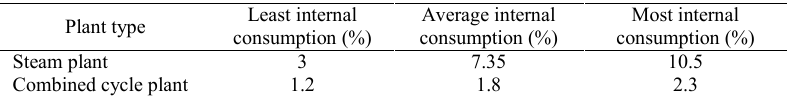
Table 2: Plant internal consumption scenarios description